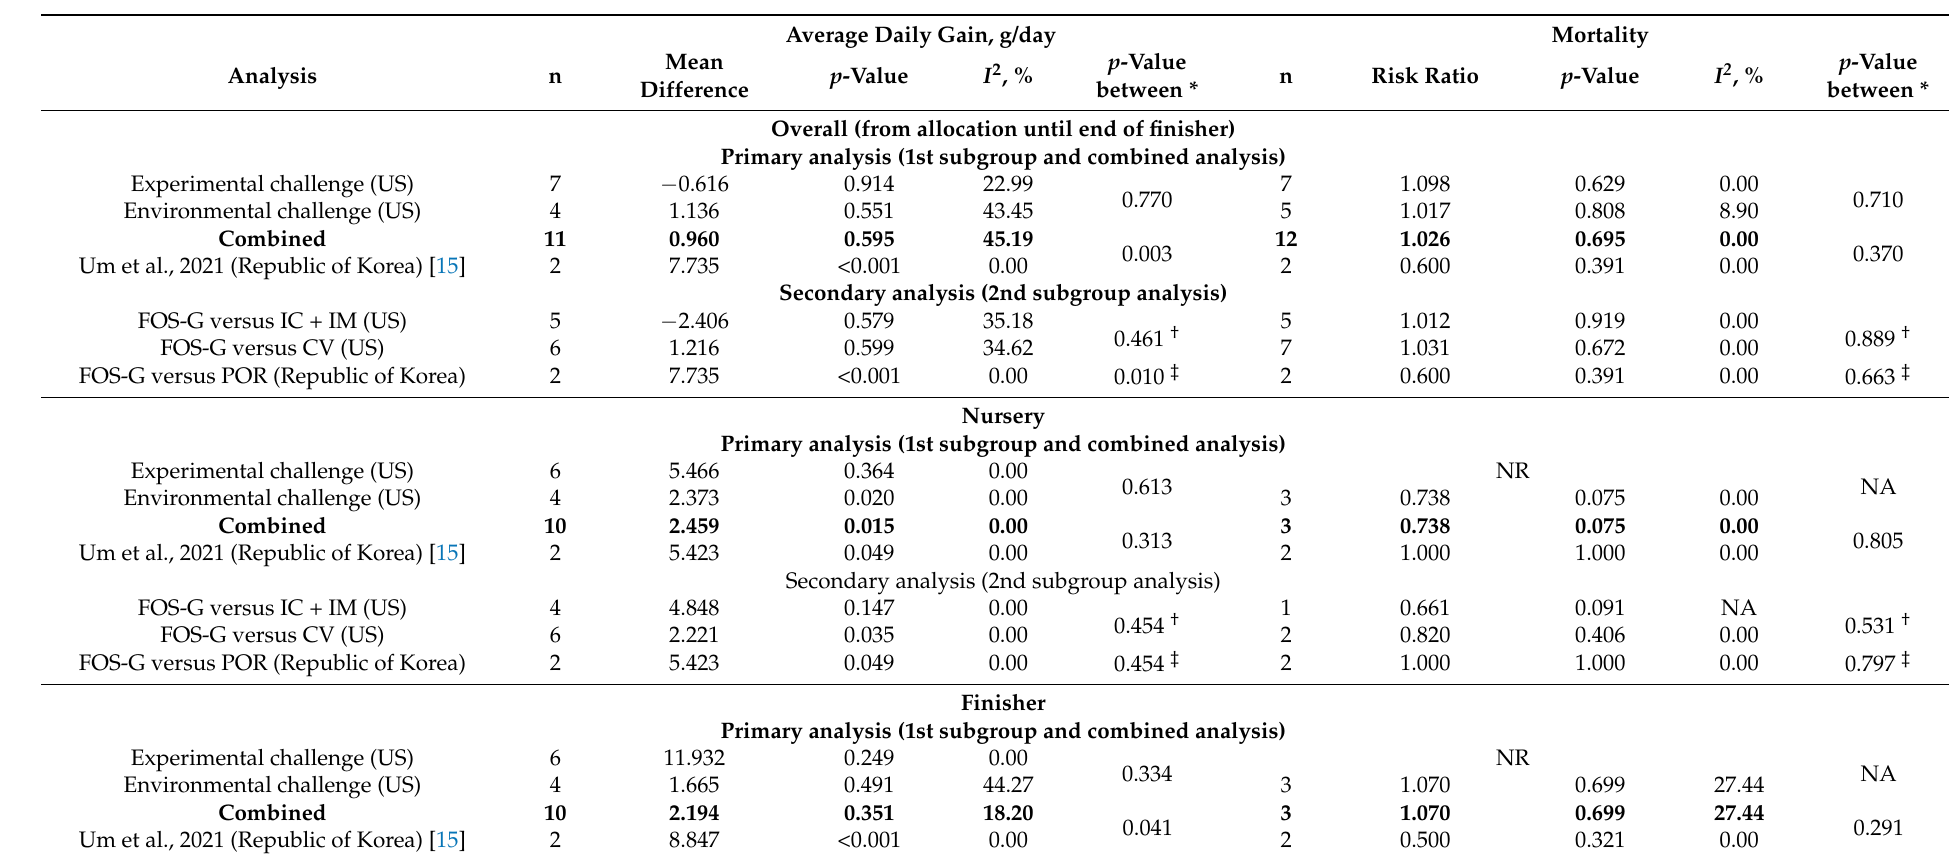
Table 3. Results of meta-analyses, evaluating the comparative efficacy of Fostera ® Gold PCV MH (FOS-G, Zoetis) on average daily gain and mortality in US field trials and a Korean